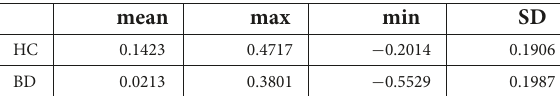
41 and 42 in the healthy controls (HC) group and the bipolar disorder (BD)